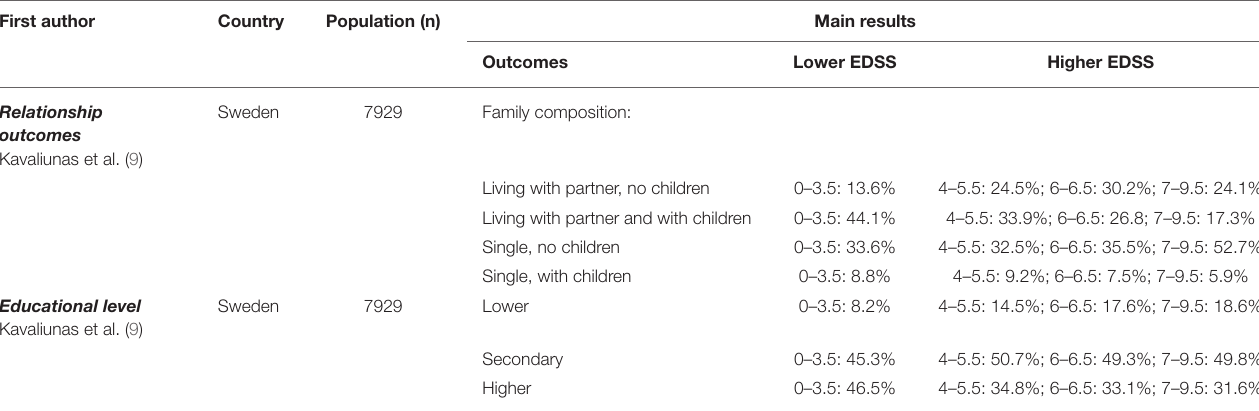
TABLE 8 | Studies that investigated relationship outcomes and educational level in patients with MS within different levels of physical